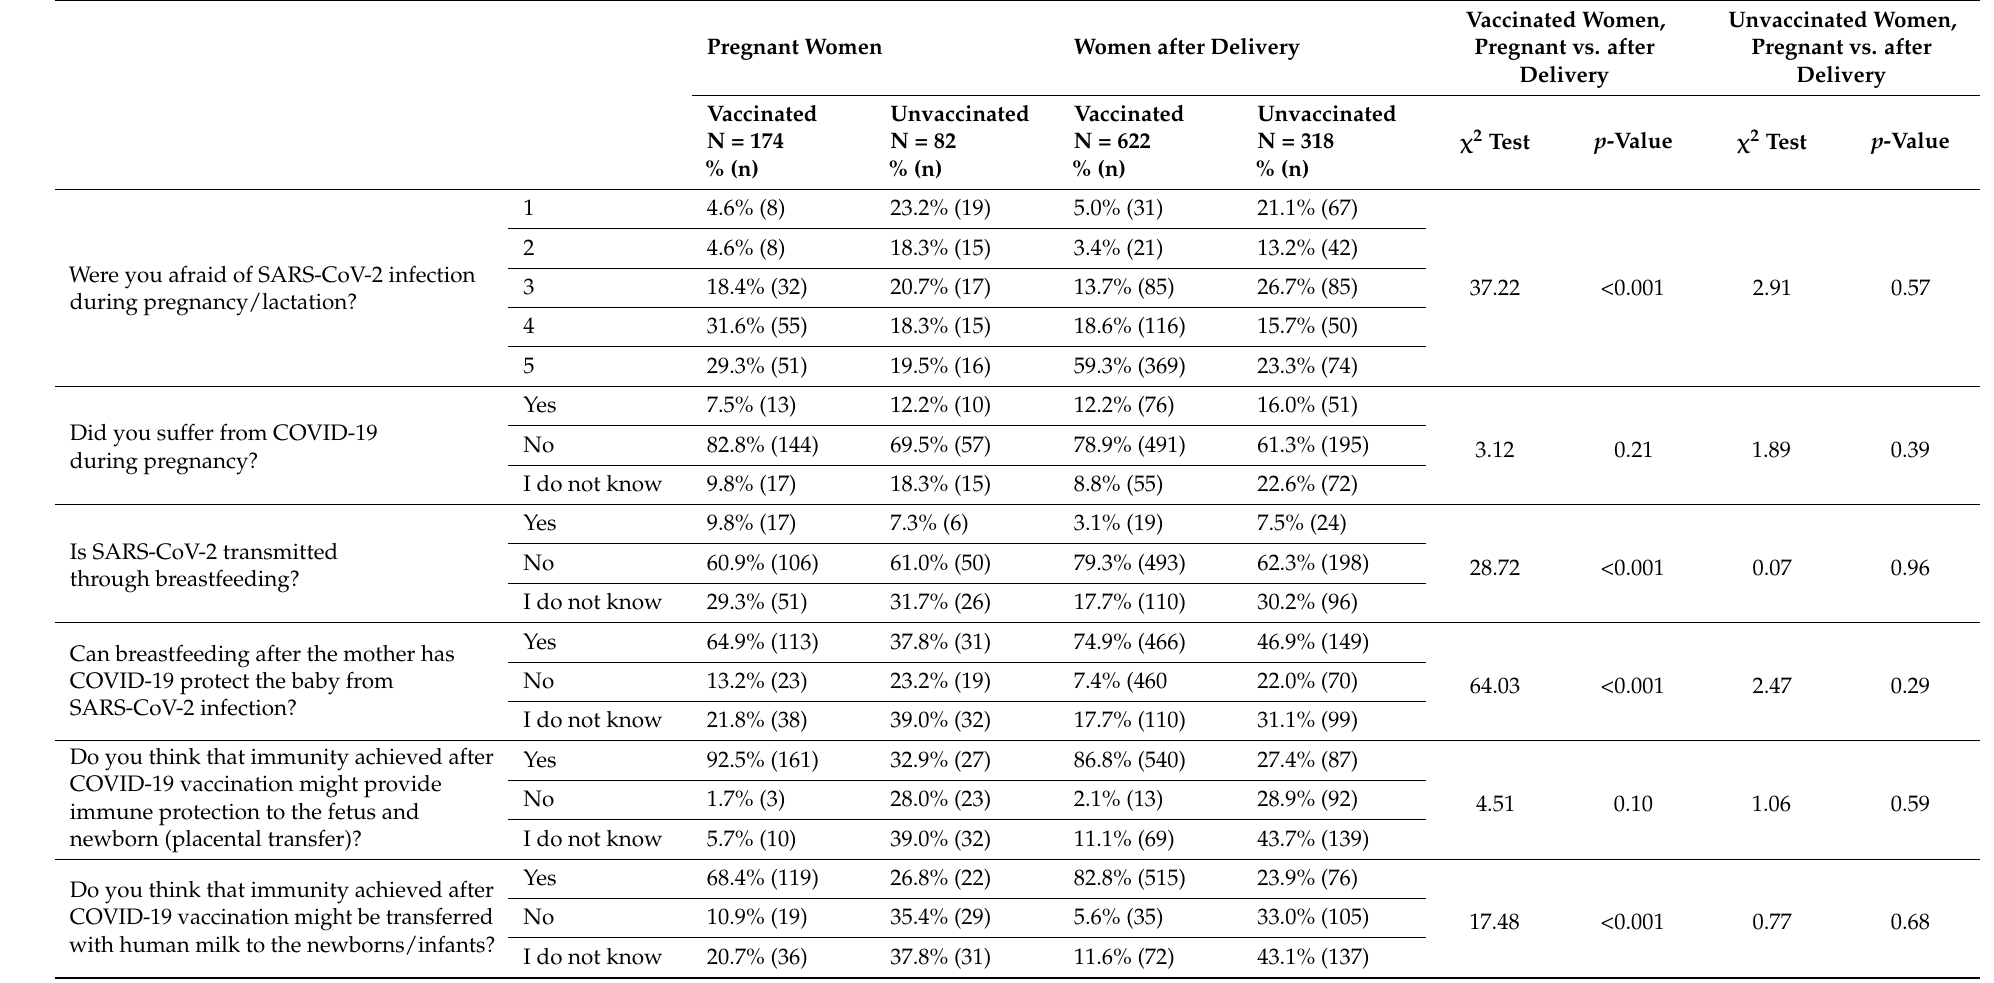
Table 5. Level of COVID-19 knowledge in relation to COVID-19 vaccination among women during pregnancy and after delivery. Pregnant Women Women after Delivery